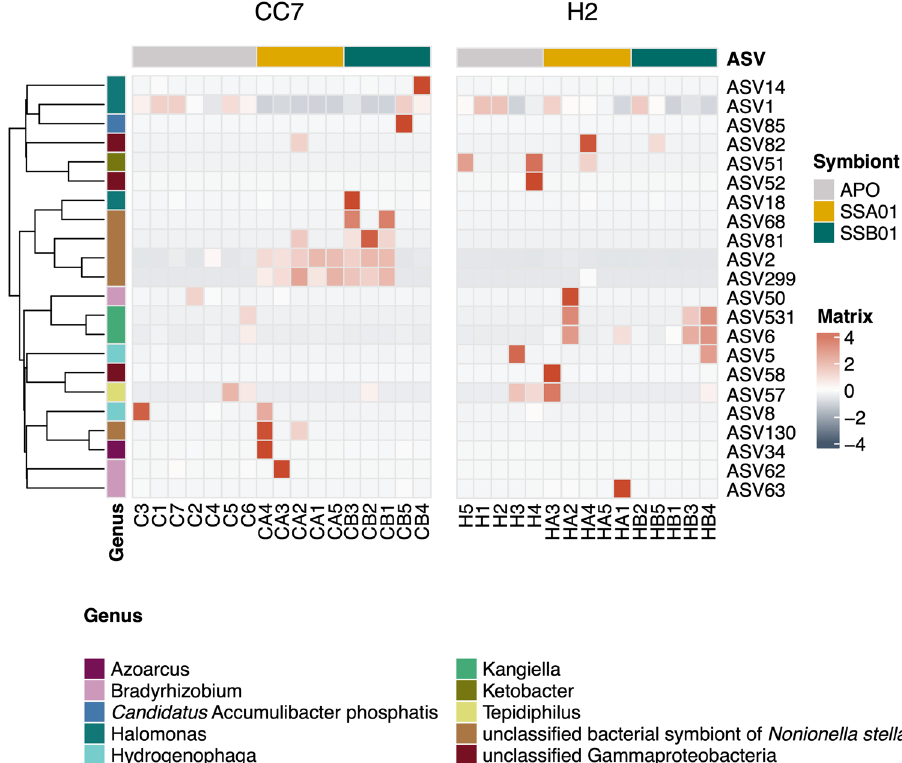
Fig. 5 Differential enrichment of denitri fi er taxa across six host-symbiont combinations of Aiptasia. Heatmap showing the signi fi cantly enriched amplicon sequence variants (ASVs) across